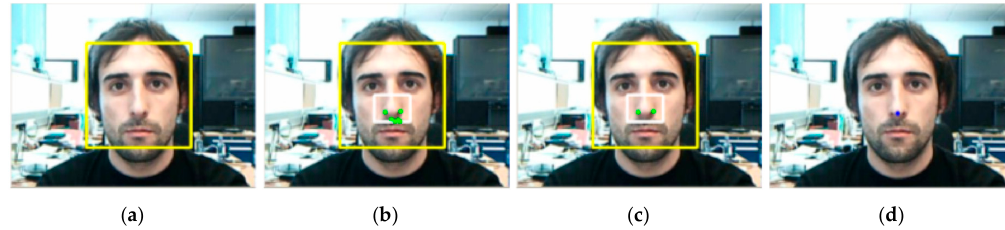
Figure 2. ( a ) Automatic face detection; ( b ) Initial set of features; ( c ) Feature re-selection using symmetrical constraints; ( d ) Mean of the selected features: nose point .